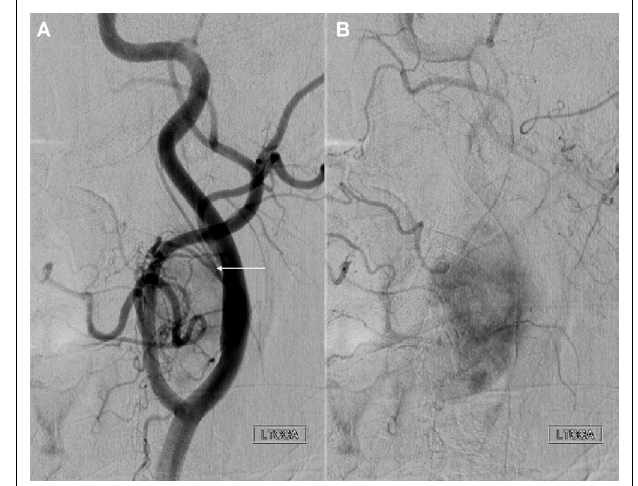
FIGURE 7 |Anteroposterior projection of a left common carotid artery injection demonstrates a large hypervascular tumor at the carotid bifurcation consistent with a paraganglioma. Characteristics including splaying of the internal and external carotid arteries (A) and intense tumor blush (B) are shown. Arterial supply includes branches of the ascending pharyngeal artery (arrow) arising from a common pharyngo-occipital trunk (not shown) that originates from the internal carotid